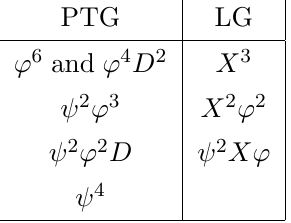
Table 2 . PTG and LG classes of operators shown in table